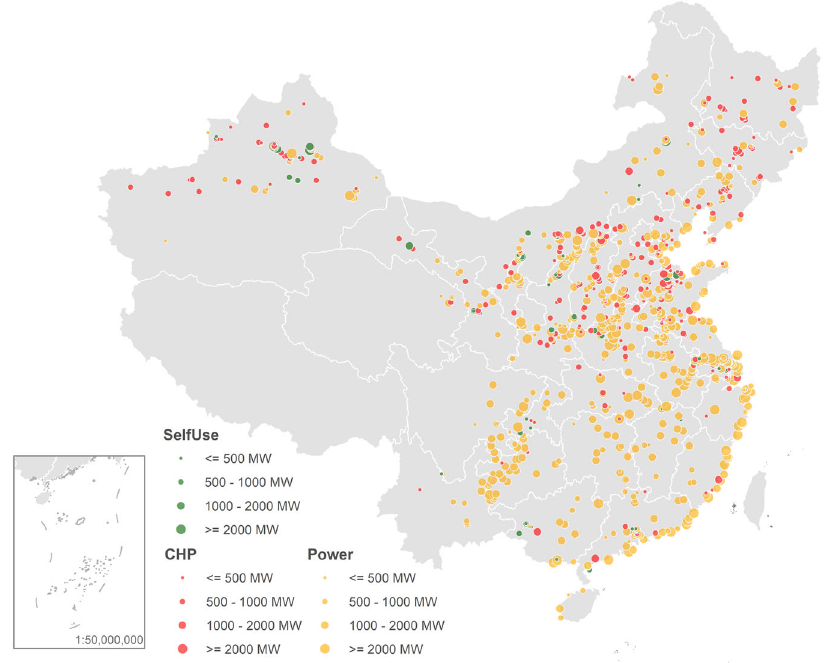
Fig. 1 Location, size, and application of existing coal plants in China. Our data covers a total of 1037 coal plants, nearly 3000 individual units (See Data in Methods). Plant size shows the sum of total capacity of all units. Application categorizes coal plants into three types: industrial self-use (captive) plants (SelfUse in green), combined heat and power plants (CHP in red), and power only plants (Power in